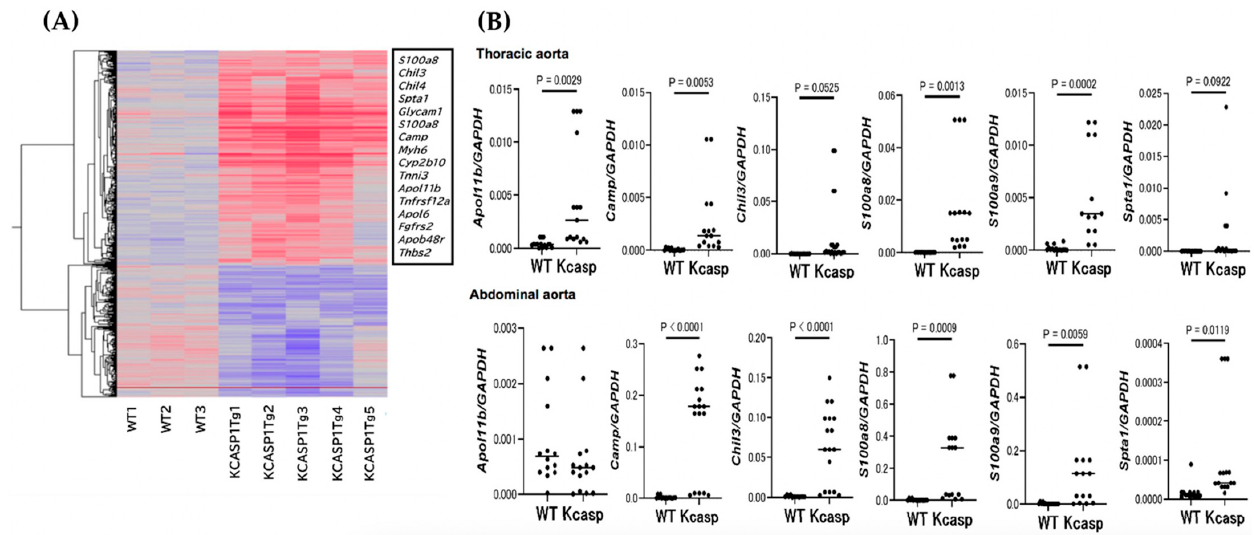
Figure 3. GeneChip and real-time PCR analysis for the thoracic and abdominal aorta. The gene expressions of Apol11b , Camp , Chil3 , S100a8 , and, S100a9 , Spta1 have upregulated genes in the abdominal aorta of KCASP1Tg mice ( A ). RT-PCR analysis showed mRNAs for Camp , Chil3 , S100a8 , S100a9 , and Spta1 were upregulated genes in the abdominal aorta of KCASP1Tg mice compared to WT mice. On the other hand, the messages for Apol11b , Camp , S100a8 , and S100a9 were increased in the thoracic aorta. n = 15, for each group. Two group comparison was analyzed with the Mann-Whitney test ( B ).